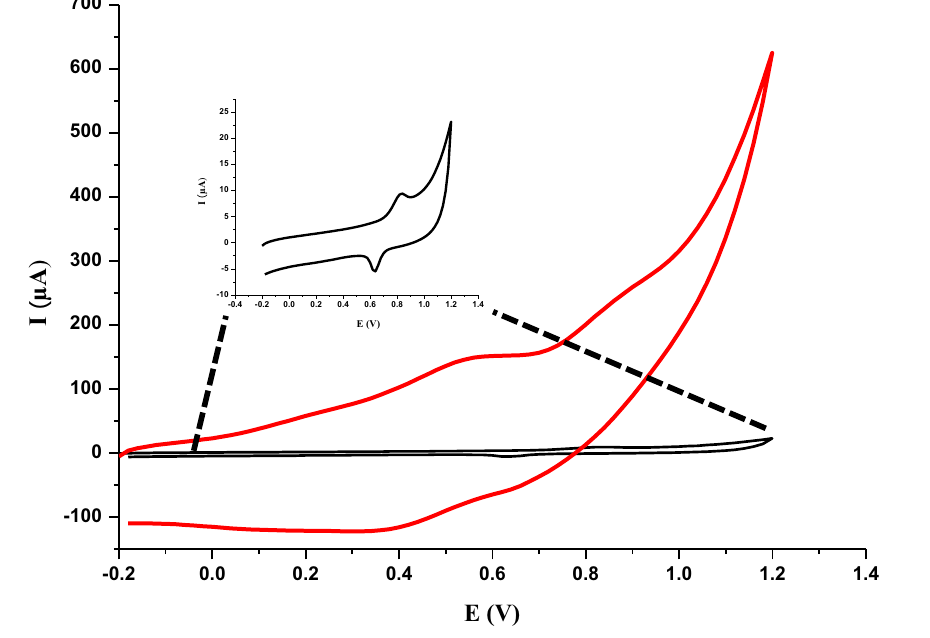
Figure 6. Cyclic voltammograms of 5 × 10 –6 M IDA on bare GCE and